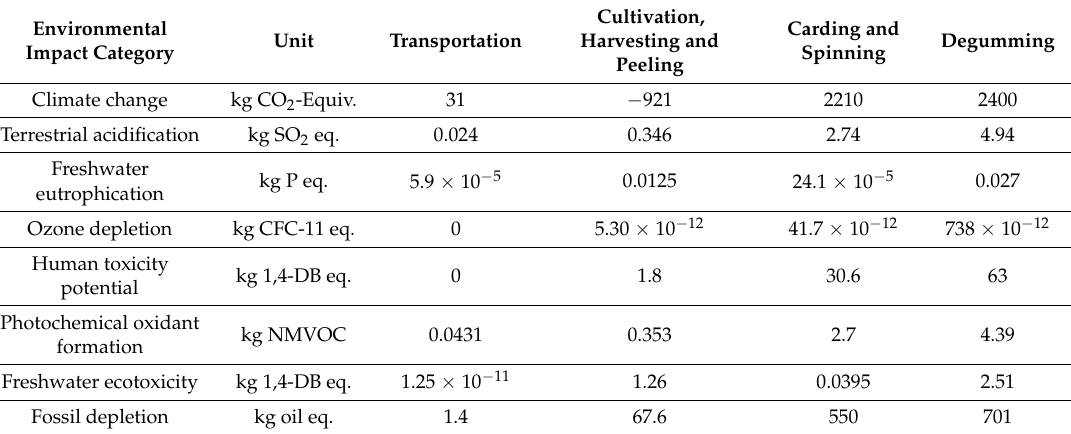
Table 6. Values of the eight categories contributed by different production processes of ramie yarns. Environmental Unit Transportation Impact Category